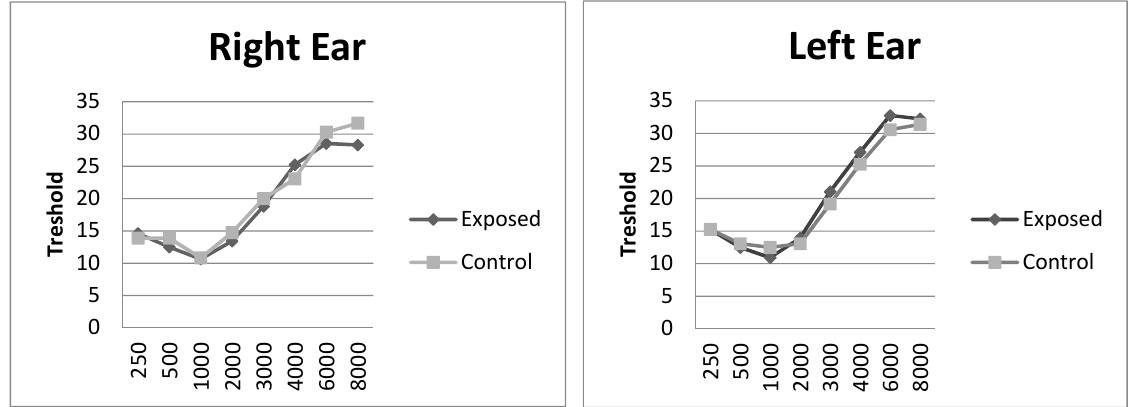
Figure 1. Mean auditory thresholds of the participants of the study—exposed group (N = 38) and control group (N = 18). The means and standard deviations of the absolute latencies (I, III, and V), interpeak latencies (I–III, III–V, and I–V), and amplitude of waves I and V of participants with pure- tone auditory threshold up to 25 dB HL are shown in Table 2 and Figure 2, according to right and left ear. There was a significant statistical difference between the groups in the latencies of waves III and V, and interpeak latencies I–III and I–V of both ears. The EG had longer wave and interpeak latencies compared to those of the CG. Such a difference was not observed in the latency of wave I, interpeak interval III–V, or amplitude of waves I’ and V’ (Table 2). Table 2. Mean and standard deviation of absolute latencies, interpeak latencies, and amplitudes of waves I’ and V’ obtained from the right and left ears of the exposed and control groups, with audi- tory thresholds of 25 dB HL at the frequencies from 2000 to 4000 Hz.